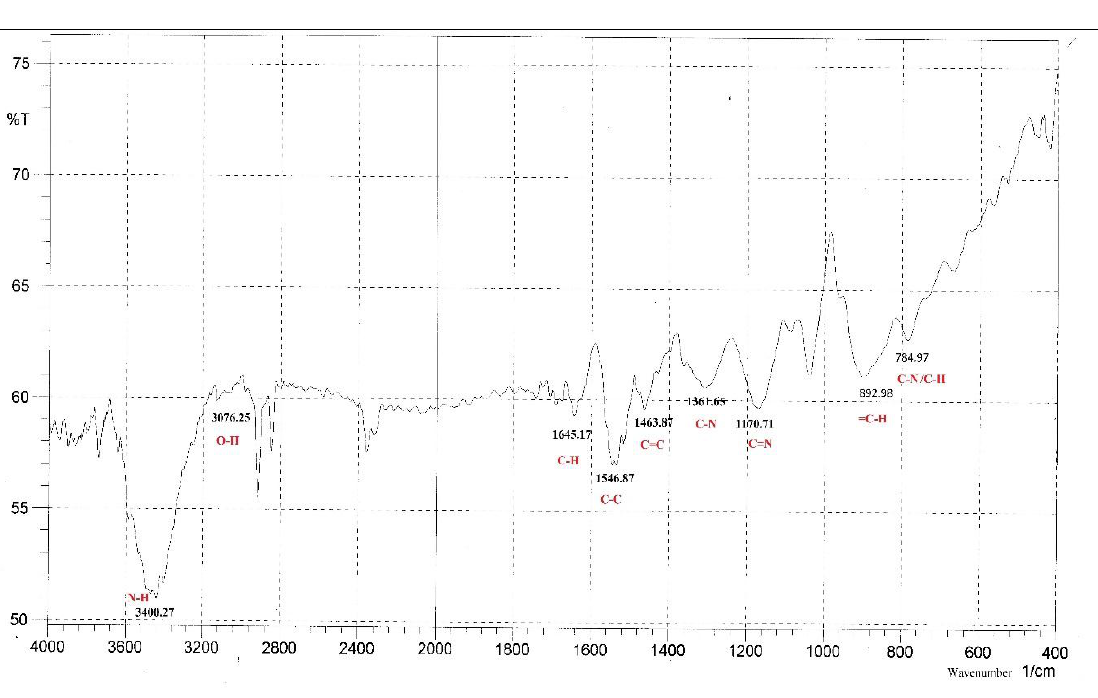
Fig.6: FTIR spectra of pure